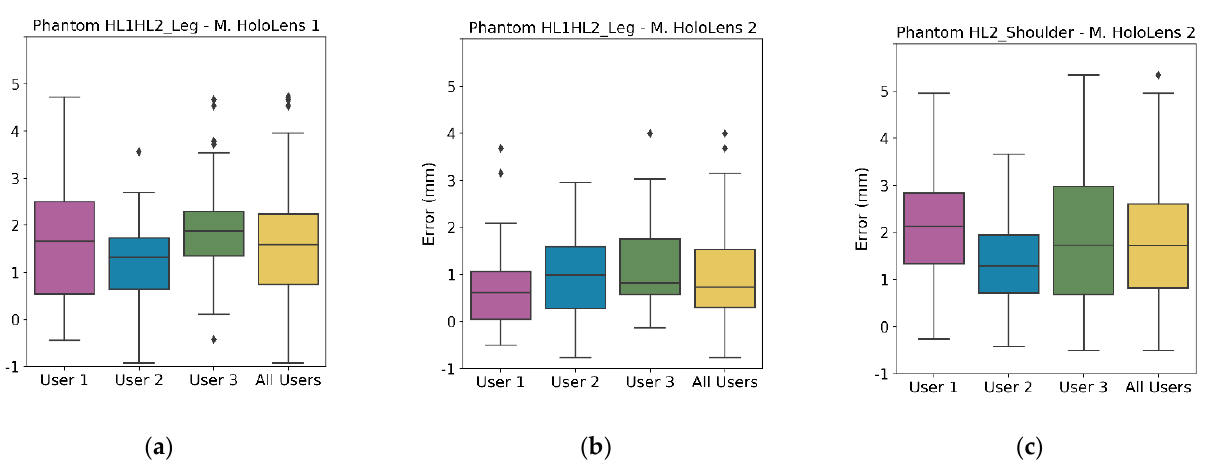
Figure 4. AR projection error for ( a ) Microsoft HoloLens 1 and ( b ) Microsoft HoloLens 2 in phantom HL1HL2_Leg, and ( c ) phantom HL2_Shoulder, grouped by user. Each box includes from first to third quartile of the dataset, with middle line indicating the median, and whiskers for the highest and lowest values (±1.5 times the standard deviation). Black diamonds represent outliers.